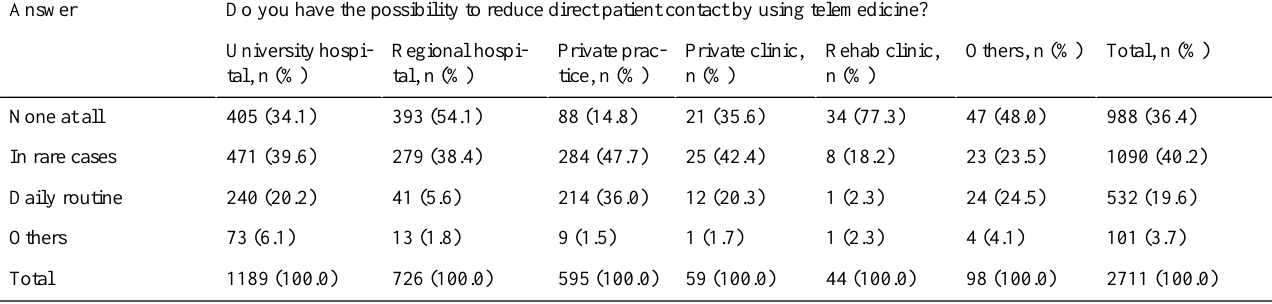
Table 3. Availability of telemedicine in different medical settings. Do you have the possibility to reduce direct patient contact by using telemedicine?Answer